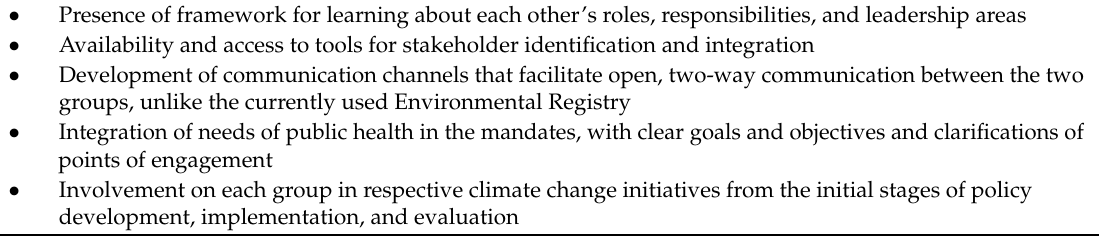
Table 5. How to leverage communication between PH and NPH